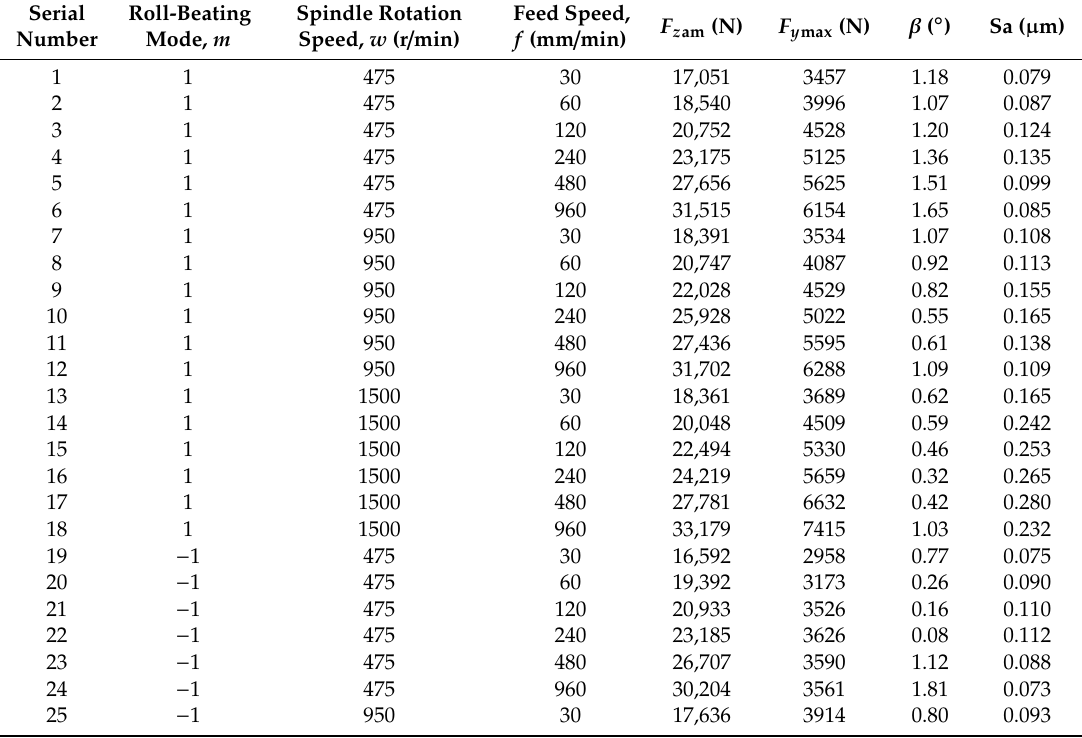
Table 3. CRBF experimental